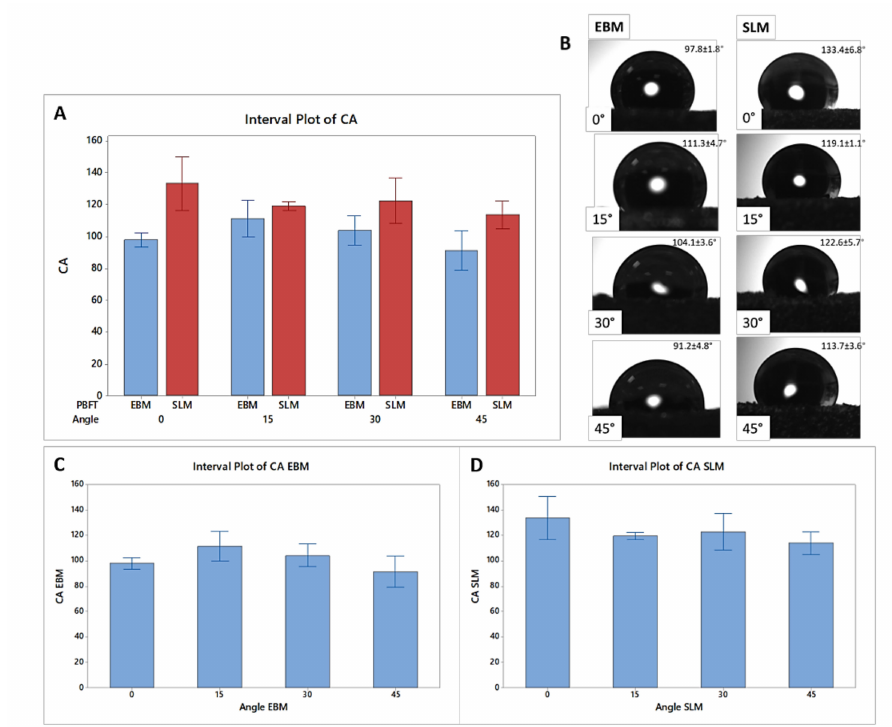
Figure 3. Contact angle (CA) measurements for the EBM and SLM samples: ( A ) comparison between average data within each group and ( B ) images of the water droplets on the top surfaces at di ff erent building angles; contact angle measurement for the ( C ) EBM individual samples and ( D ) SLM individual samples.